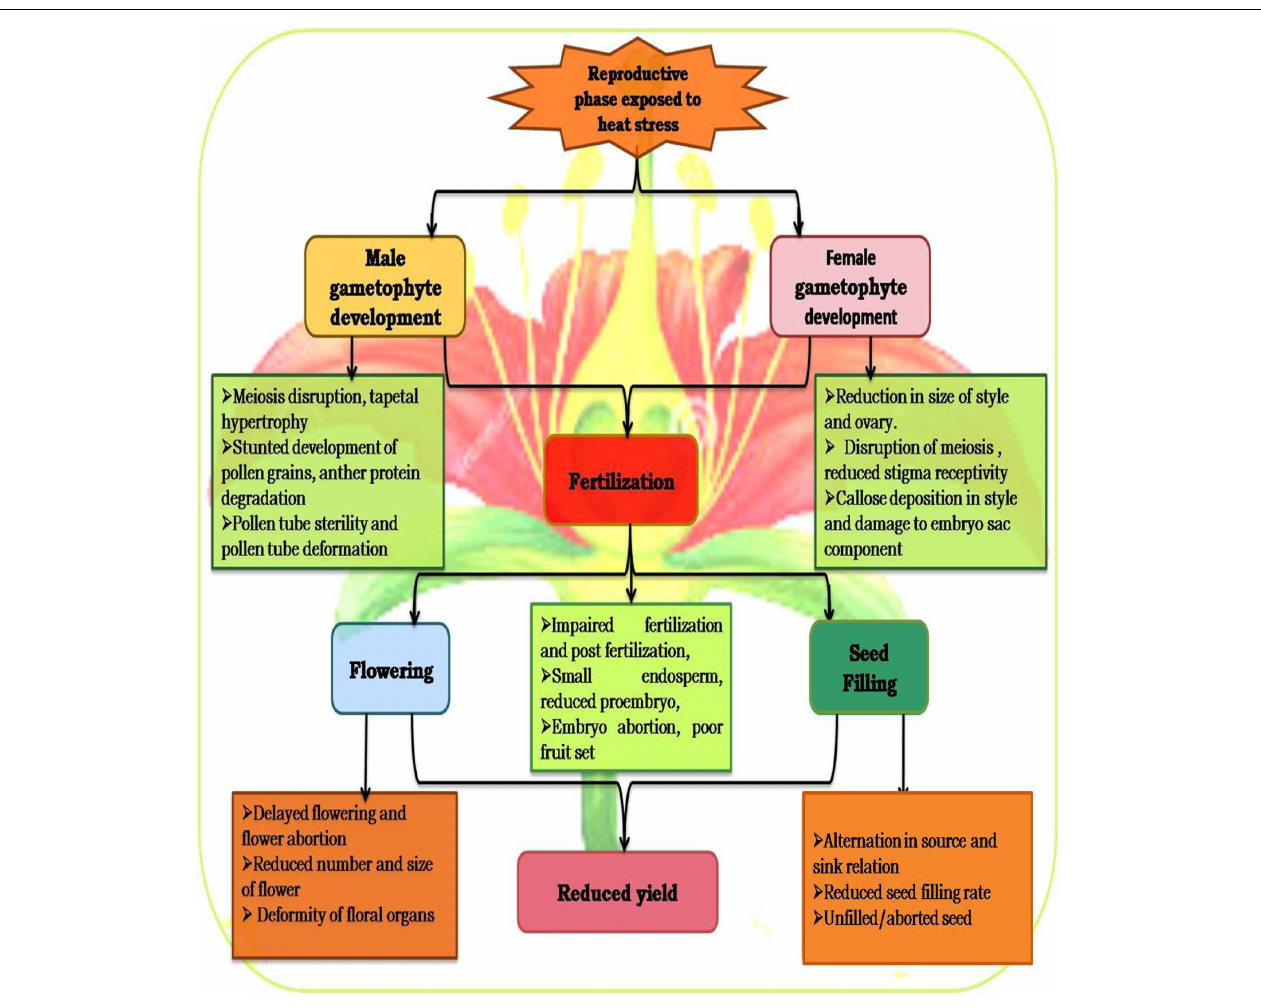
FIGURE 4 | Effects of heat stress during the reproductive phase (at different functional